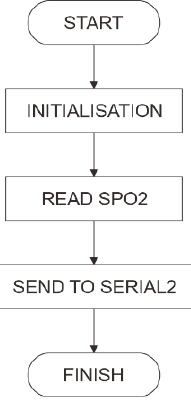
Figure 10 . Reading process of max30102 by ESP32.